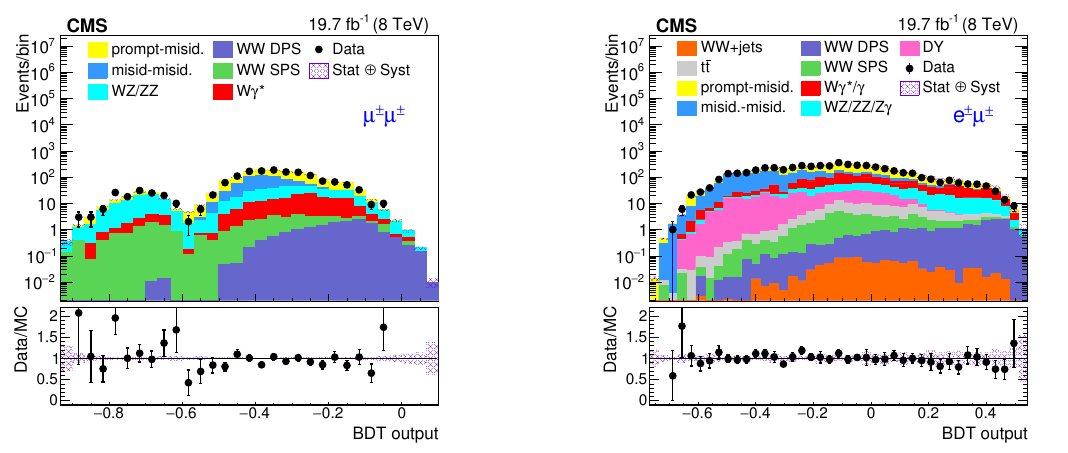
Figure 4 . Distribution of the BDT discriminant, for the dimuon channel (left) and for the electron- muon channel (right). The data are represented by the black dots and the shaded histograms represent the pre-(cid:12)t signal and post-(cid:12)t background processes. The bottom panels show the ratio of data to the sum of all signal and background contributions. The hatched bands represent the post-(cid:12)t uncertainty, which includes both the statistical and systematic components.